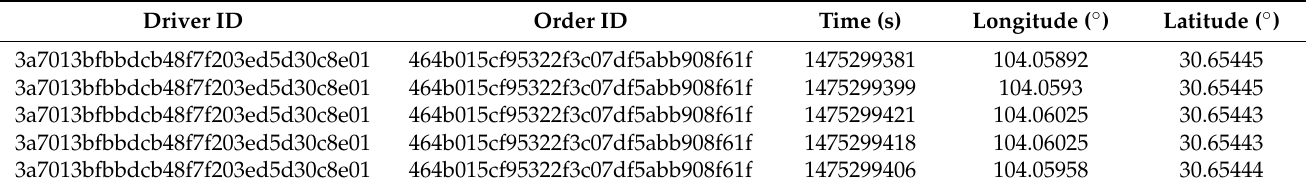
Table 1. Trajectory